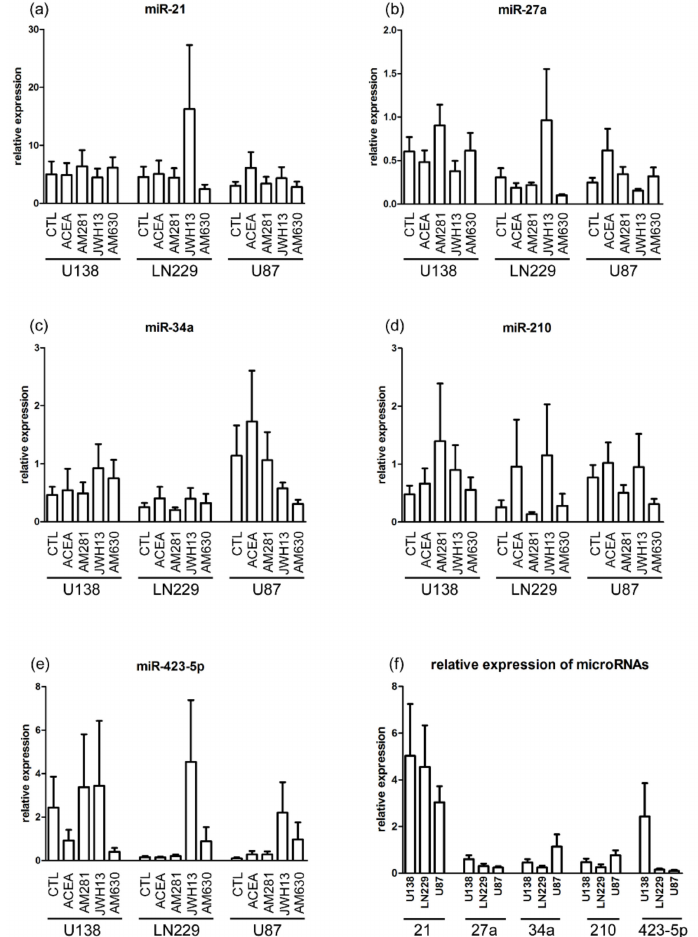
Figure 1. Analysis of the microRNA (miR) profile in glioblastoma cell lines after treatment with agonists (ACEA, 10 µ M; JWH133, 10 µ M) and antagonists (AM281, 1 µ M; AM630, 1 µ M) for cannabinoid receptors (CB) 1 and CB 2 . Each sample was run in duplicates and quantified by 2 − ∆∆ C T (DCT) method. Small RNAs, SNORD44 and let-7a, were chosen as reference genes and serve as a reference according to a NormFinder analysis. ( a ) Expression of miR-21 in U-138 MG ( n = 6–8), LN229 ( n = 7–8) and U-87 MG ( n = 9–10). ( b ) Expression of miR-27a in U-138 MG ( n = 6–7), LN229 ( n = 6–8) and U-87 MG ( n = 9–10). ( c ) Expression of miR-34a in U-138 MG ( n = 6–7), LN229 ( n = 6–8) and U-87 MG ( n = 9–10). ( d ) Expression of miR-210 in U-138 MG ( n = 6–7), LN229 ( n = 6–8) and U-87 MG ( n = 8–10). ( e ) Expression of miR-423-5p in U-138 MG ( n = 5–7), LN229 ( n = 5–7) and U-87 MG ( n = 9–10). ( f ) No significant differences could be observed in the expression of miRs 21, 27a, 34a, 210, and 423-5p between the control